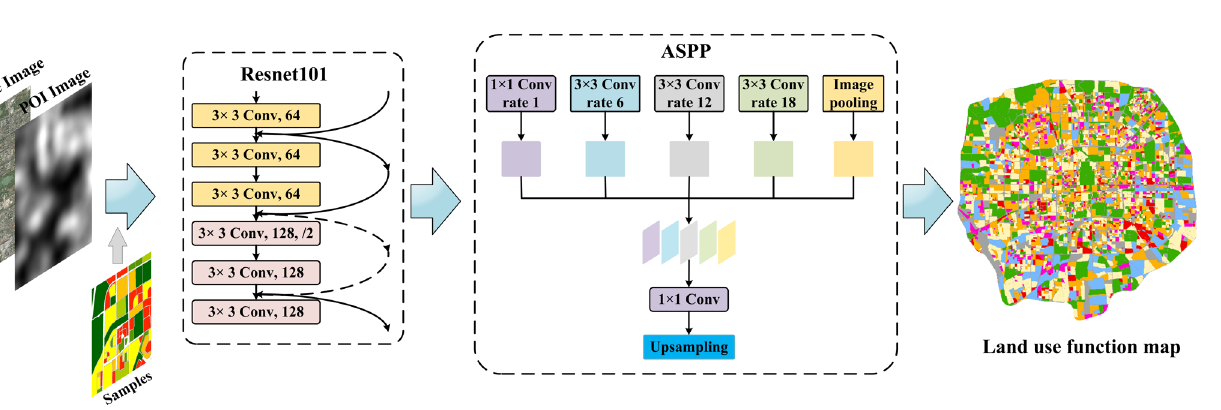
Figure 5. The generated land-use function map.